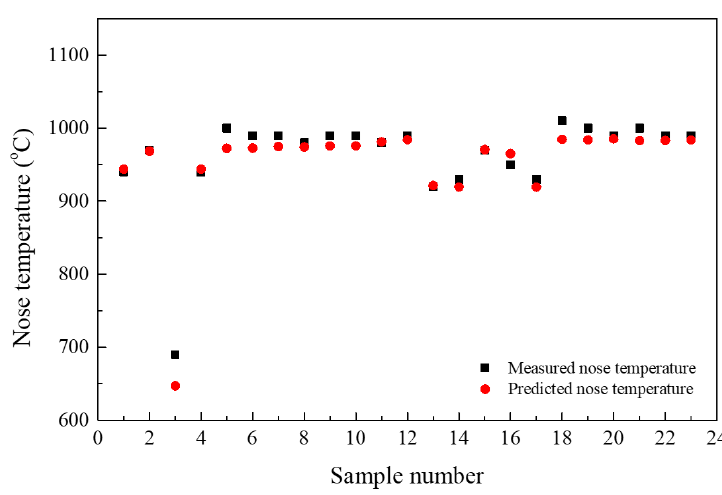
Figure 11. Comparison of nose temperatures with reference compositions.